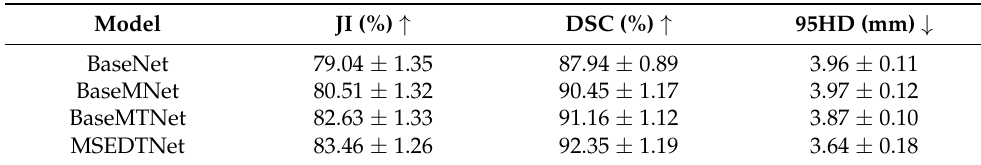
Table 2. Segmentation results on different ablation models.